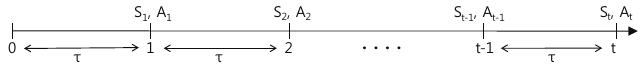
Figure 3. Timing